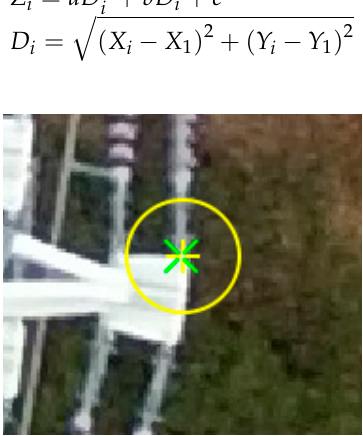
Figure 5. Example of the point of support at the tower structure.